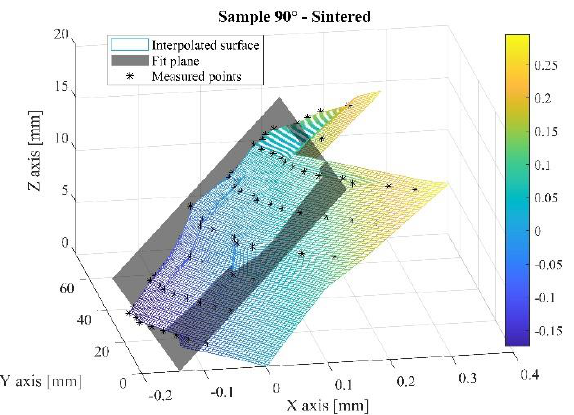
Figure 12. Sample 90°, points measured at the sintered state and reconstruction of the plane.